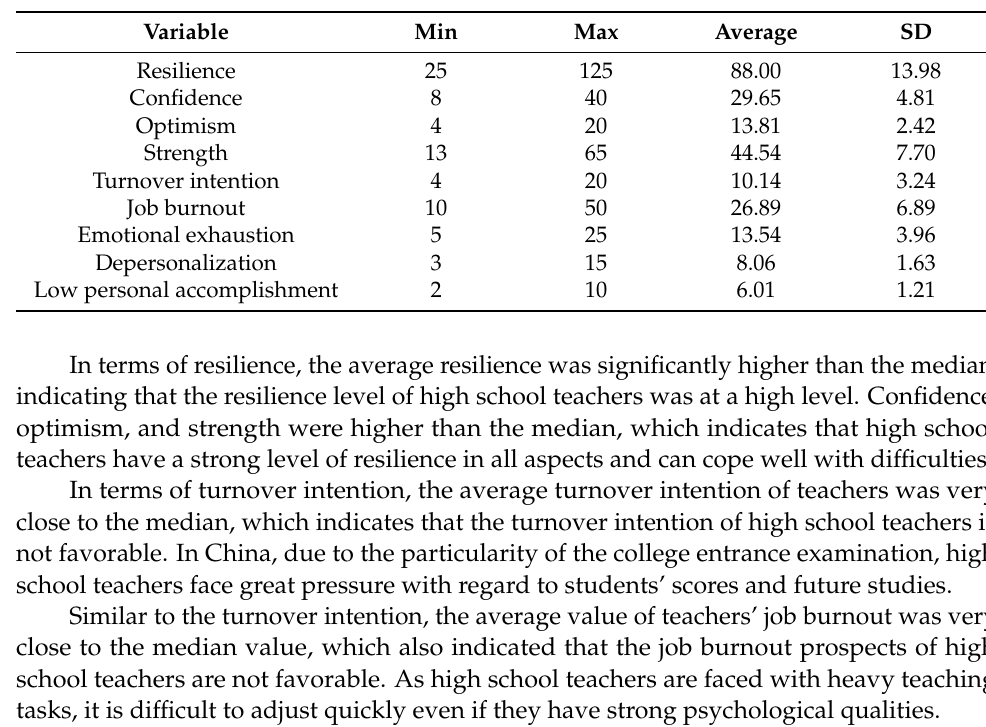
Table 1. Descriptive